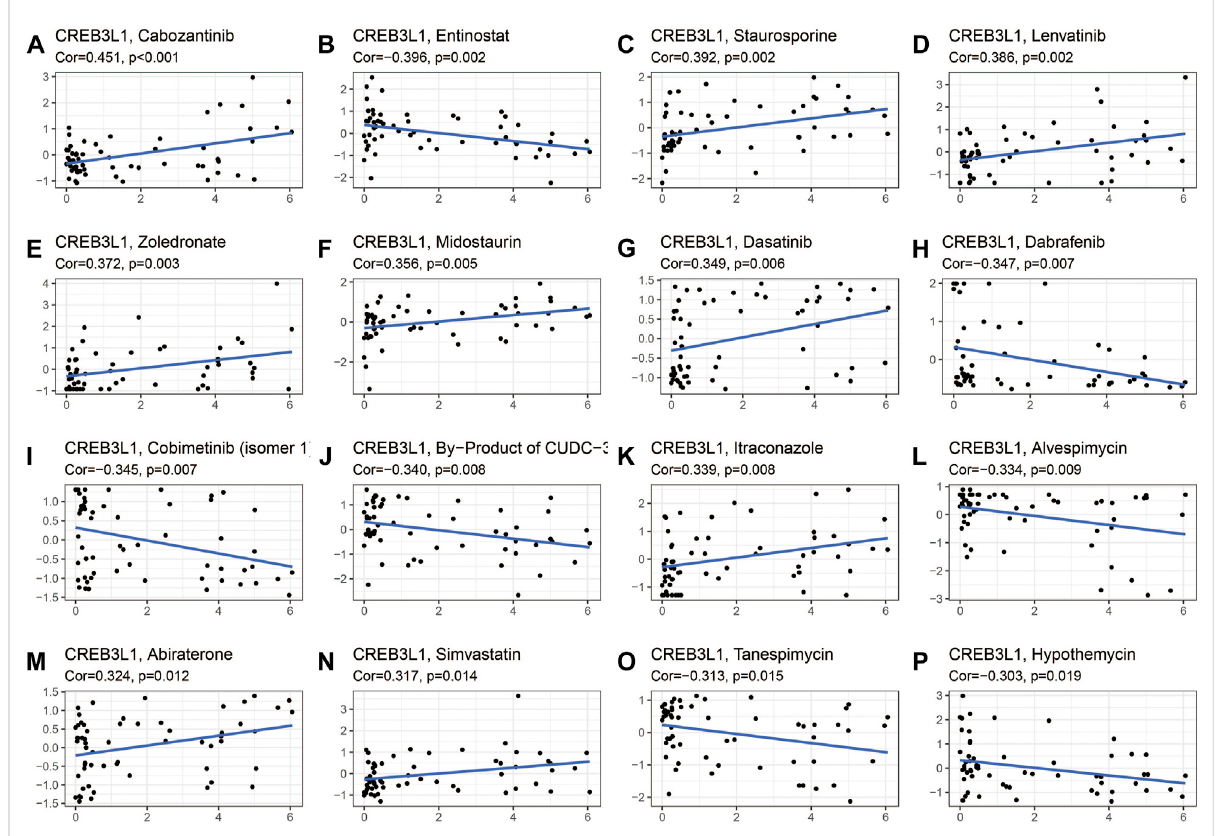
FIGURE 10 The correlation between CREB3L1 expression and drug sensitivity. The CREB3L1 was linked to the sensitivity of (A) cabozantinib, (B) entinostat, (C) staurosporine, (D) lenvatinib, (E) zoledronate, (F) midostaurin, (G) dasatinib, (H) dabrafenib, (I) cobimetinib (isomer1), (J) By-Product of CUDC- 305, (K) itraconazole, (L) alvespimycin, (M) abiraterone, (N) simvastatin, (O) tanespimycin, and (P)